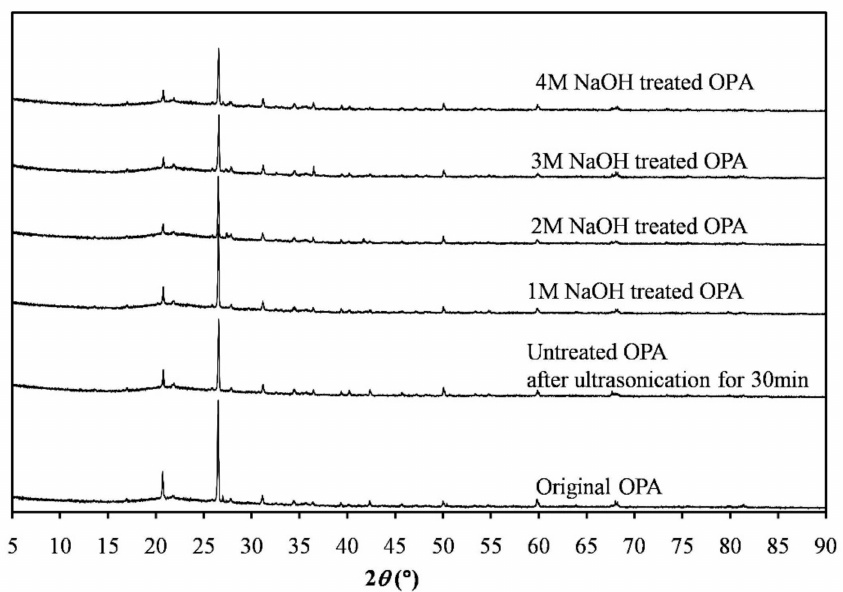
Figure 7. XRD patterns of original OPA, untreated OPA by ultrasonication for 30 min and treated OPA with NaOH at different concentrations followed by ultrasonication for 30 min. Table 6. FTIR frequencies of both untreated OPA and 3M NaOH-treated OPA samples. Vibration Frequencies (cm − 1